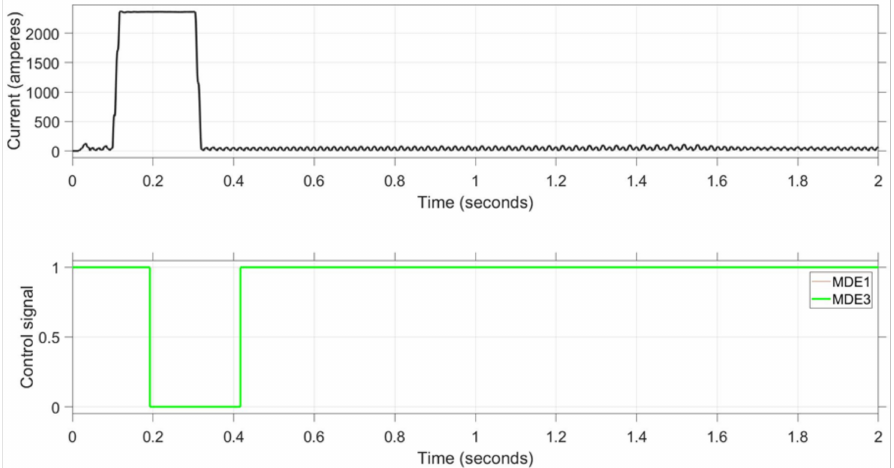
Figure 9. Recloser response for MDE1 and MDE3 in case 1.